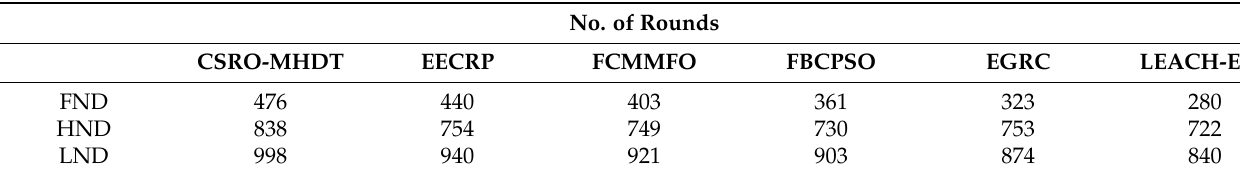
Table 3. Network lifetime analysis of the CSRO-MHDT technique in comparison with existing approaches.